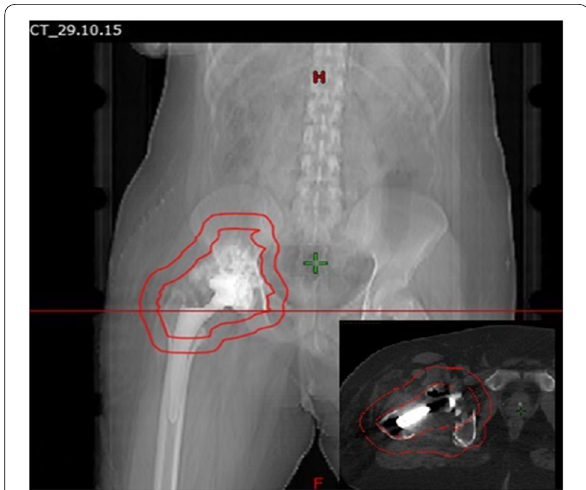
Fig. 2 Hip heterotopic ossification contouring. Orthogonal view of contouring a patient with Rt hip heterotopic ossification